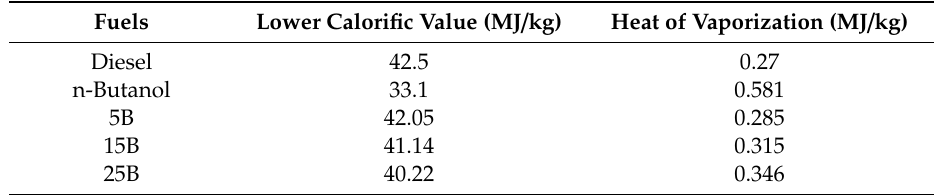
Figure 7. Variation of cylinder temperature: ( a ) BMEP 4.5 bar, injection timing 5 ° CA bTDC; ( b ) BMEP 4.5 bar, injection timing 25 ° CA bTDC; ( c ) BMEP 10.5 bar, injection timing 5°CA bTDC; and ( d ) BMEP 10.5 bar, injection timing 25 ° CA BTDC. Table 6. LCV and HV of diesel and n-butnol blends.